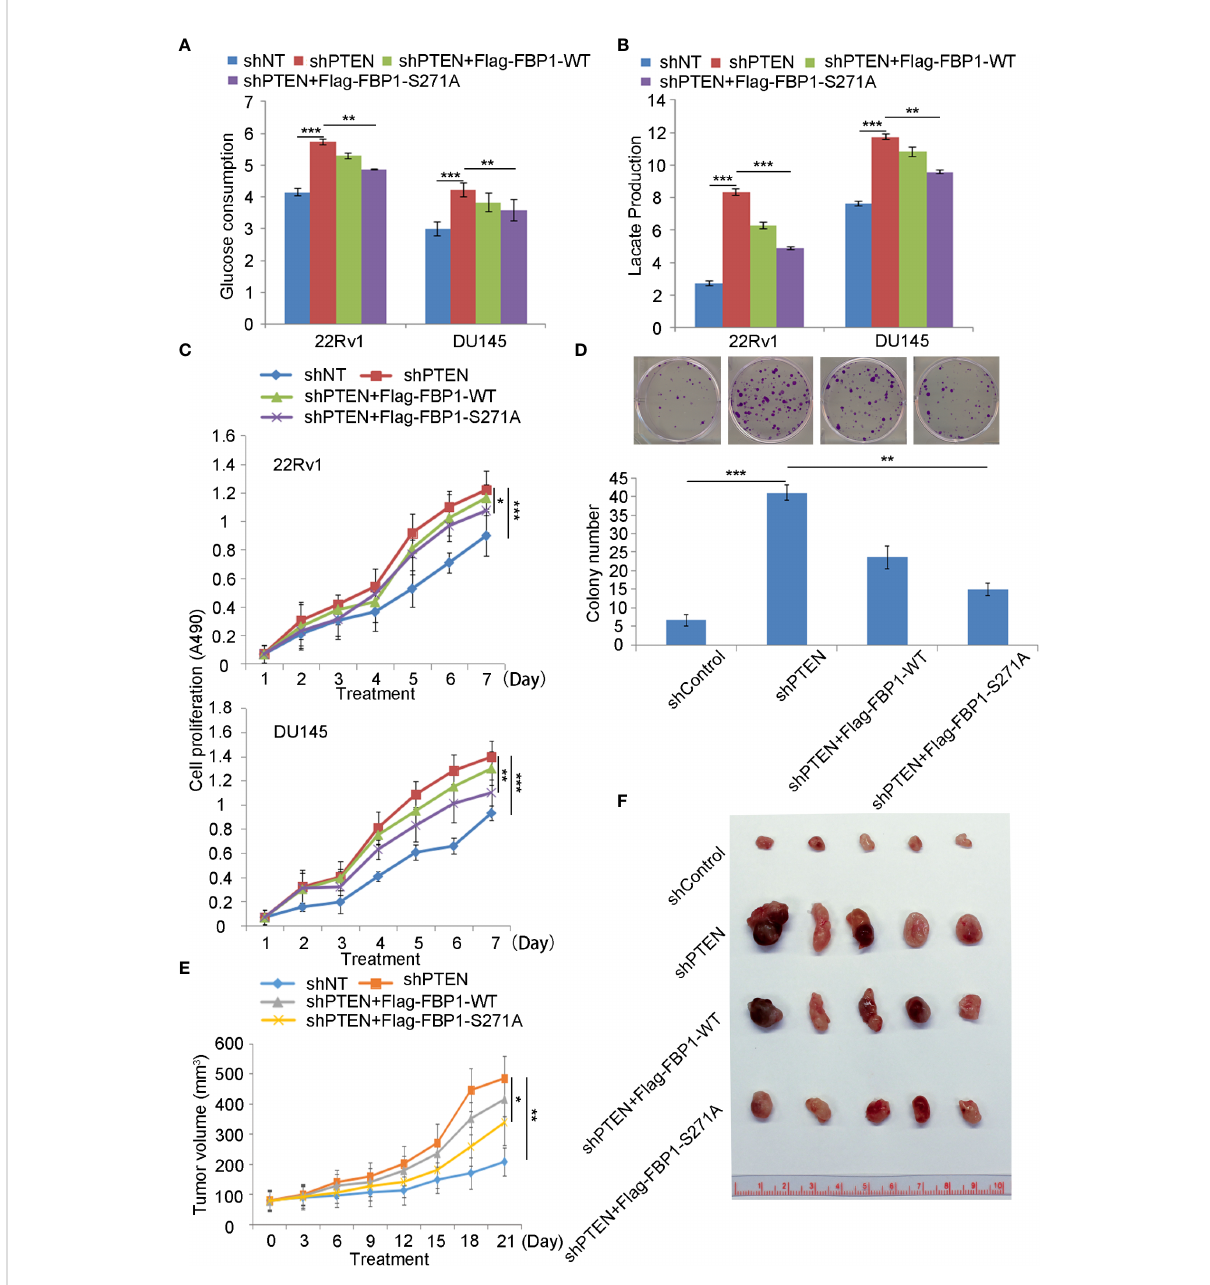
FIGURE 6 Serine 271 phosphorylation of FBP1 is important in regulating the Warburg effect and tumor growth in PCa (A, B) Glucose consumption and lactate production were measured in the spent medium of 22Rv1 and DU145 cells 48 hours after transfected with indicated constructs. All quantitative data are shown as Mean ± SD (n=3). Student ’ s t test. **P<0.01, ***P<0.001. (C) MTS assay was performed in 22Rv1 and DU145 cells 48 hours after transfected with indicated constructs for different periods of time. All quantitative data are shown as Mean ± SD (n=3). Student ’ s t test. *P<0.05, ***P<0.001. (D) Representative images were taken and quanti fi cation of the results of colony formation assays was performed in DU145 cells transfected with indicated constructs for 13 days. All quantitative data are shown as Mean ± SD (n=3). Student ’ s t test. **P<0.01, ***P<0.001. (E, F) Tumor growth curve over the time (E) and photograph (F) of tumors at the endpoint of inoculation of DU145 cells infected with lentivirus expressing indicated shRNAs or expression vectors. All quantitative data are shown as Mean ± SD (n=3). Student ’ s t test.